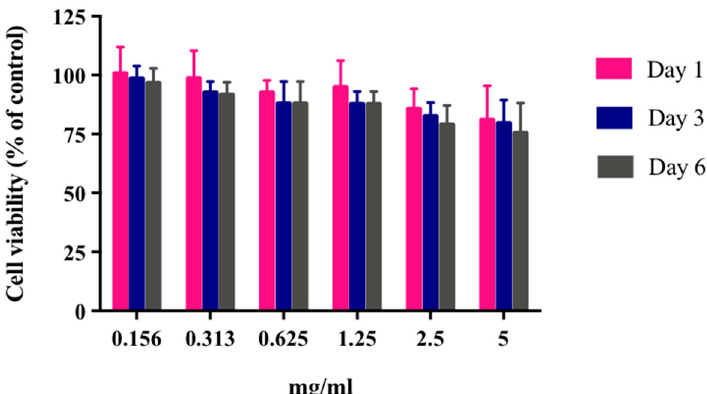
Figure 12. Effect of various concentrations of γ -PGA-CH NPs on HEK293A proliferation. Samples were incubated with cells for six days and cell proliferation was evaluated at day 1, day 3 and day 6 by MTT assay ( n = 9).